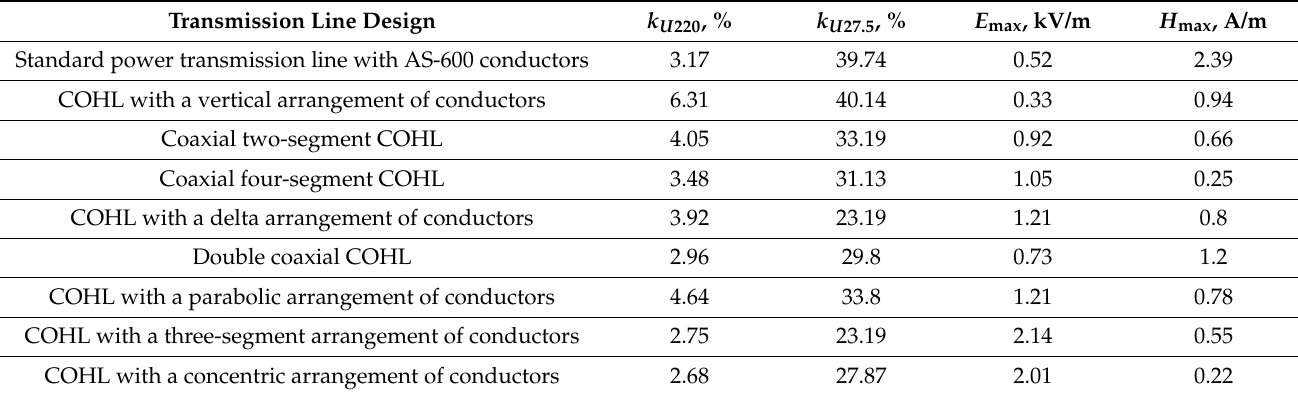
Table 2. Maximum values of